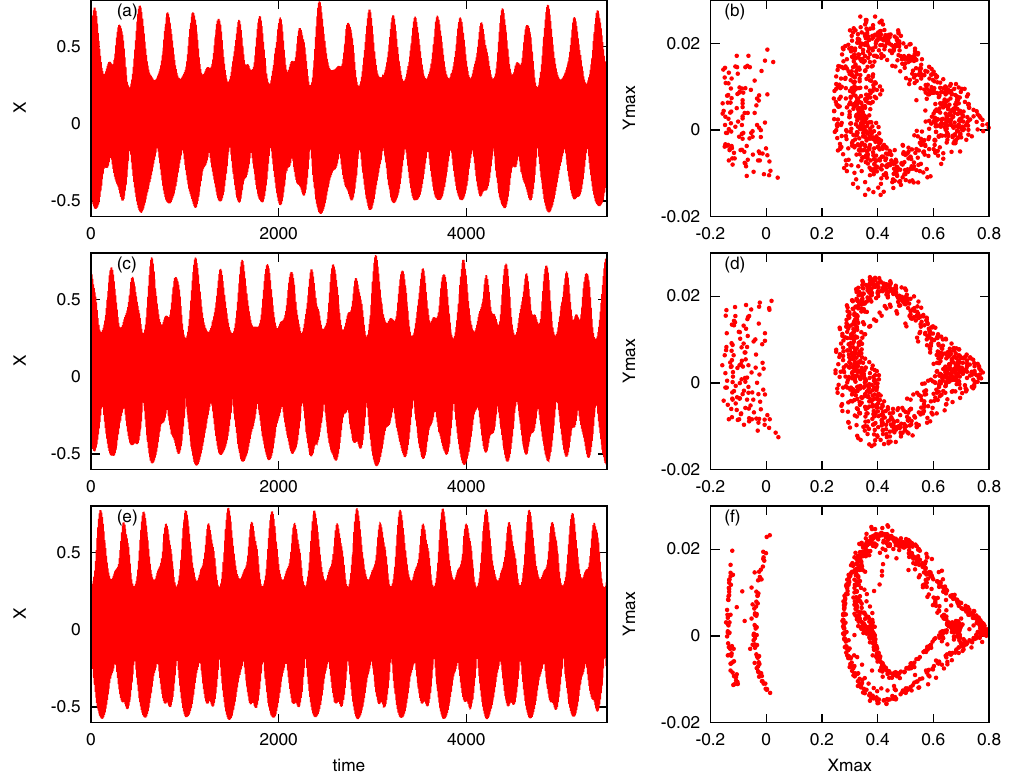
Figure 4. Relation between compositional and dynamical properties of the mean field. We show behaviors of the mean field X ( t ) for I = 0.008 and three compositionally different states. Panels (a,b): “chimera” state; panels (c,d): clustered “chimera” state; panels (e,f): clustered state. Panels (a,c,e) show time evolution of the mean field X ( t ). Panels (b,d,f) show Poincaré maps: values of the mean fields X and θ φ = Y cos sin where X reaches local maxima. We stress here that the states are classified (“chimera”, clustered “chimera”, clustered) not according to the behavior of the mean field, but through the analysis of the instantaneous states of the units in the population, as defined above and described in section